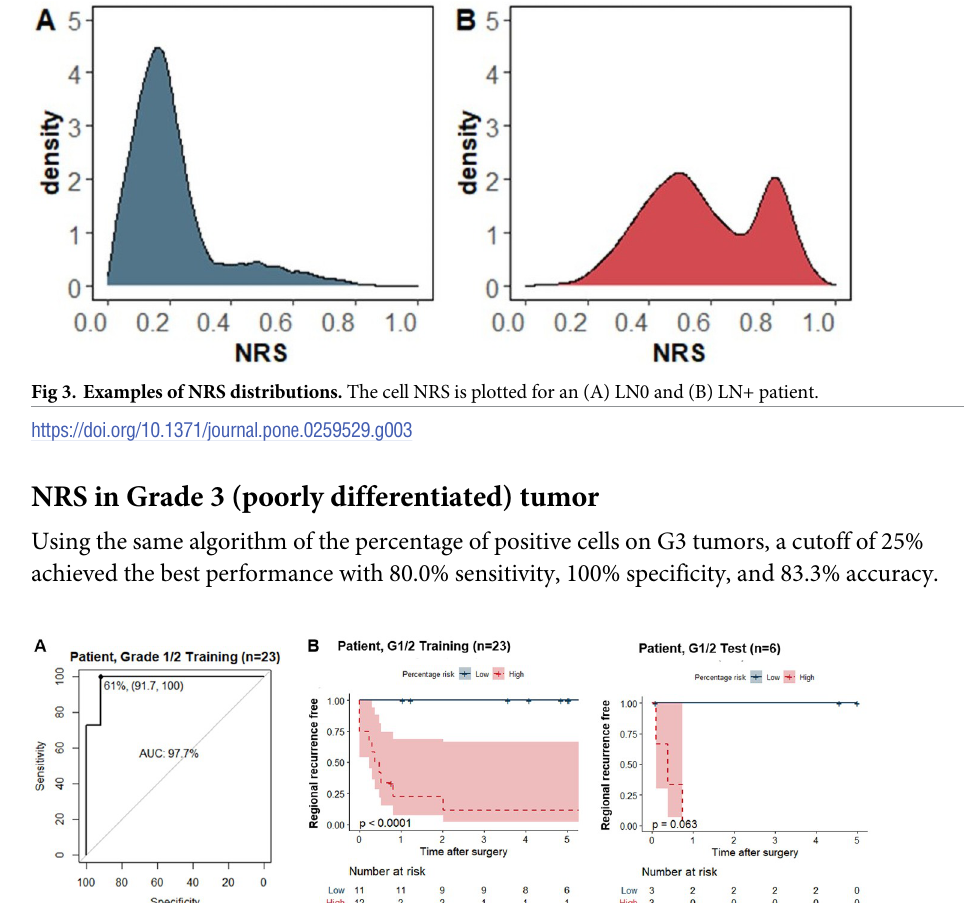
Fig 4. NRS predicted nodal risk. (A) Receiver operating characteristic (ROC) curve of the percentage of positive (NRS � 0.5) cells among Grade 1/2 training set. The best cutoff (solid black dot) gives 100% sensitivity and 91.7% specificity. (B) Kaplan-Meier curves of regional recurrence free between low risk (blue) and high risk (red) groups of patients in the training and test sets as defined by the 61% cutoff of positive cells.